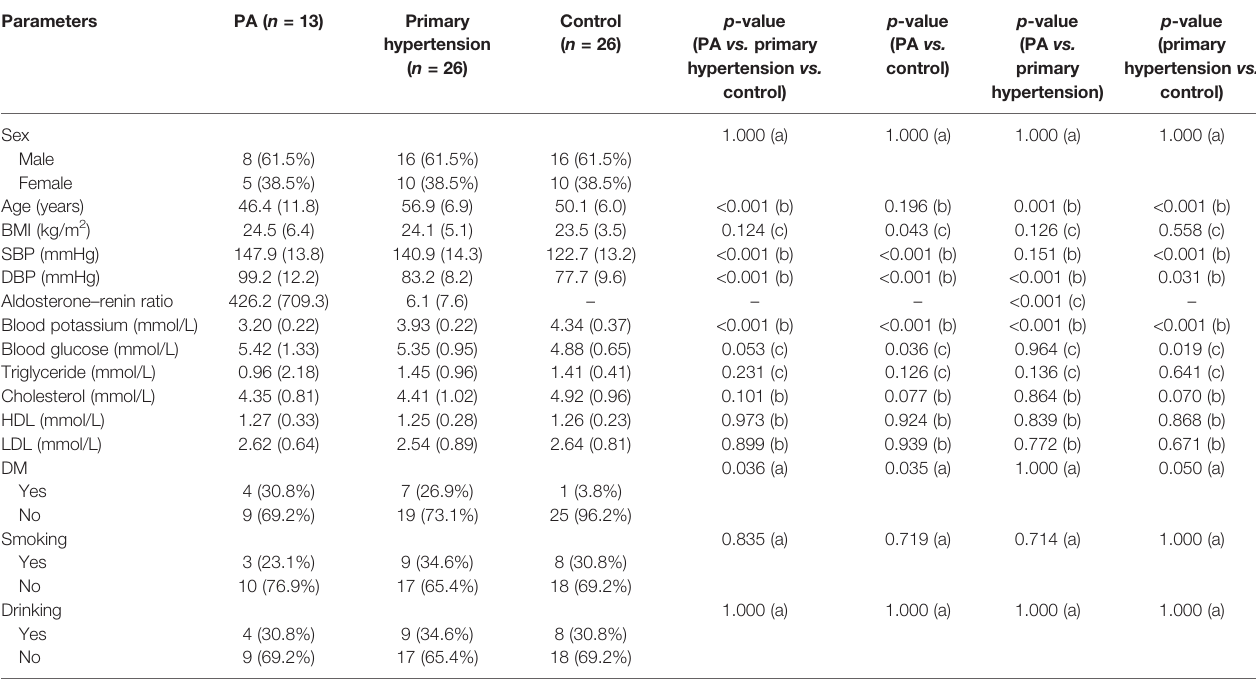
TABLE 1 | Demographic and clinical characteristics of study participants in control, primary hypertension, and PA patients. Parameters PA ( n = 13) Primary